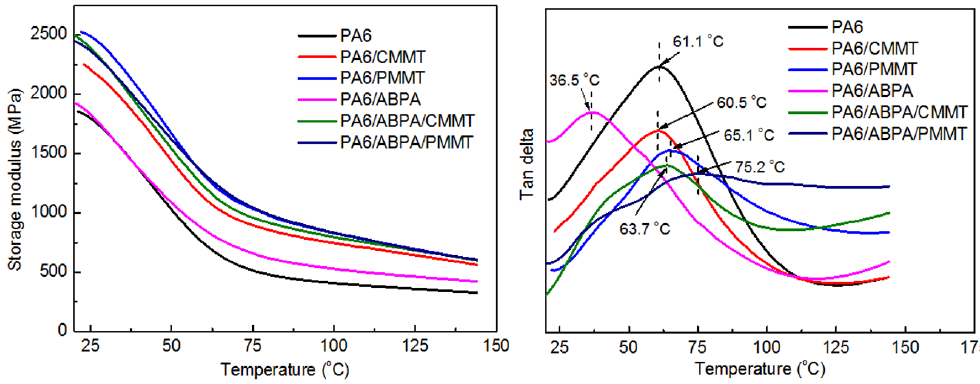
Figure 5. Dynamic storage modulus ( a ) and tan δ ( b ) vs. temperature for PA6 and various PA6 composites.